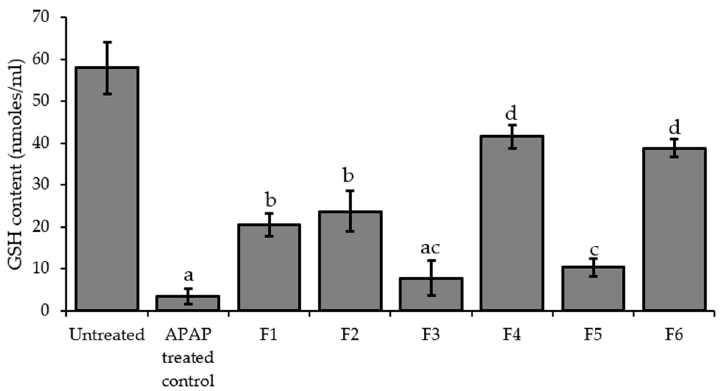
Figure 6. The effect of PPRFs on the GSH content of APAP-treated HepG2 cells. The values (mean ± SD) from three replicates of independent experiments. Bars with the same alphabets are not significantly different ( p < 0.05). APAP: Acetaminophen.